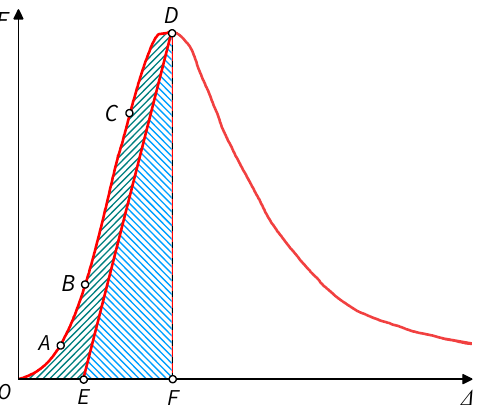
Figure 8. Schematic diagram of calculated energy dissipation.